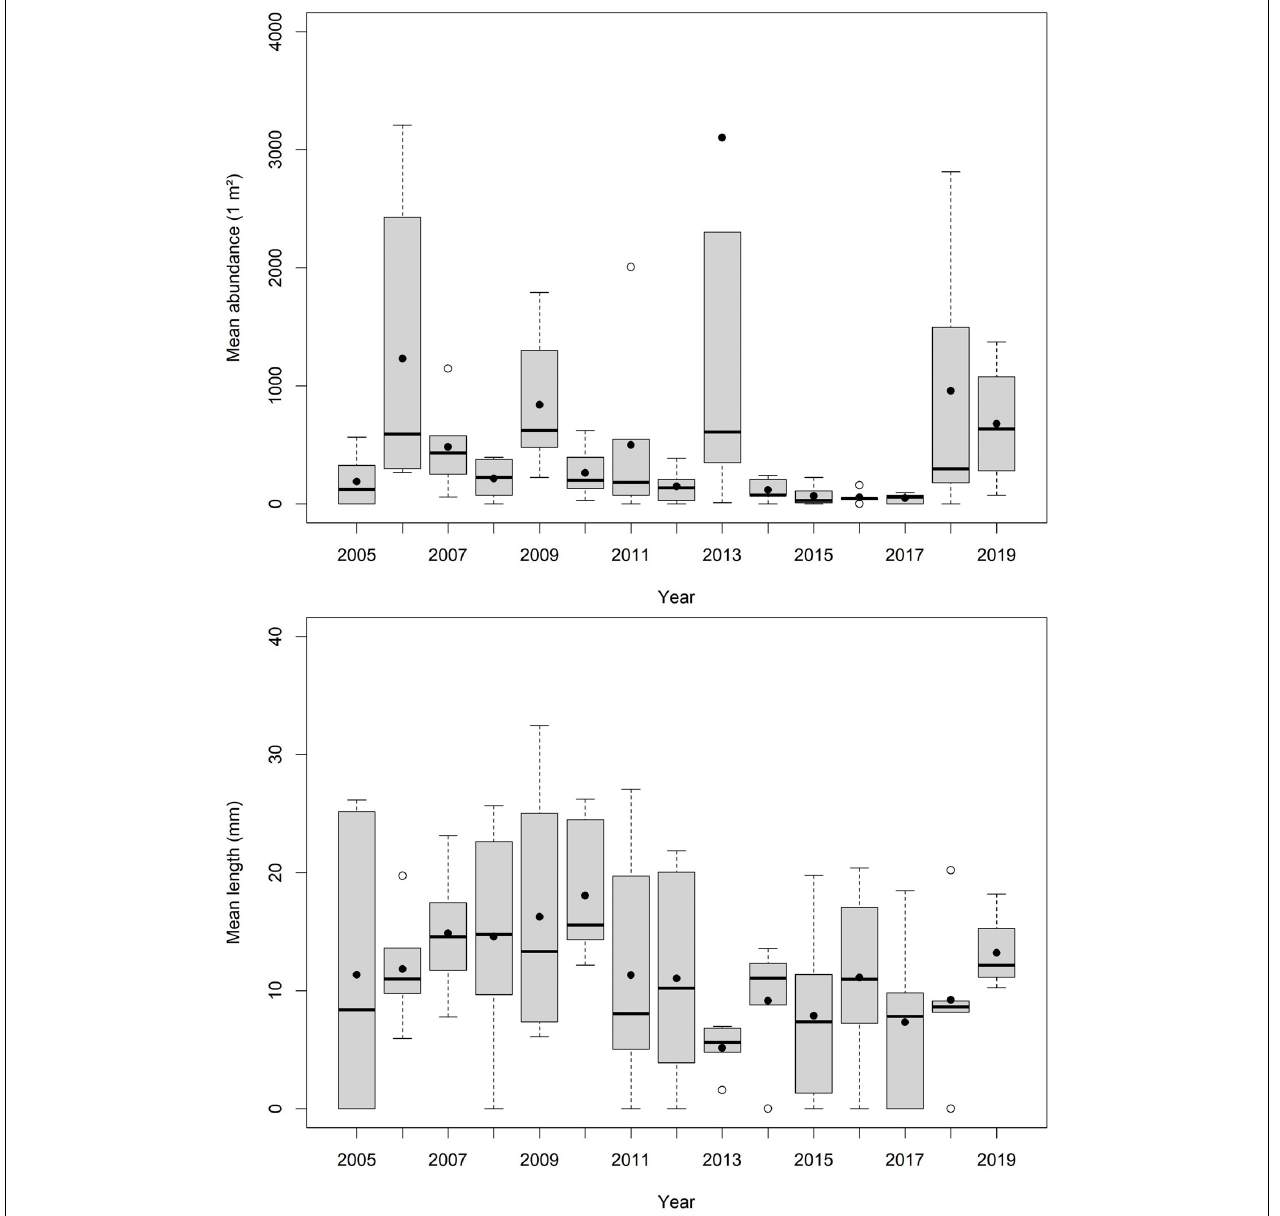
FIGURE 7 | Long-term variability in mean abundance (per m 2 ) and length (in mm) of cockles of transect M between 2005 and